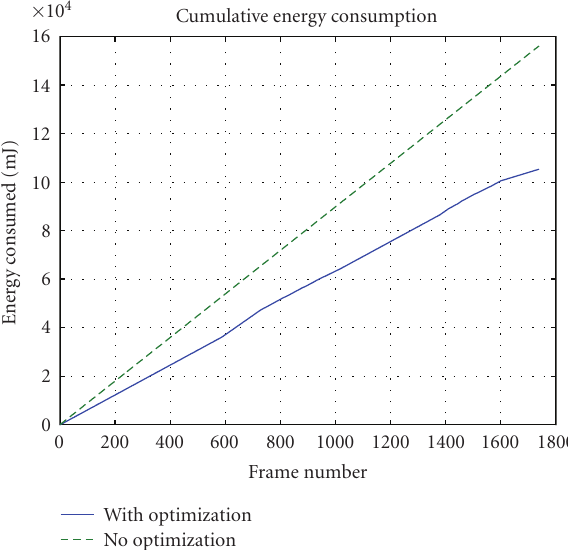
Figure 12: Energy consumption with and without optimization for abc news video clip.